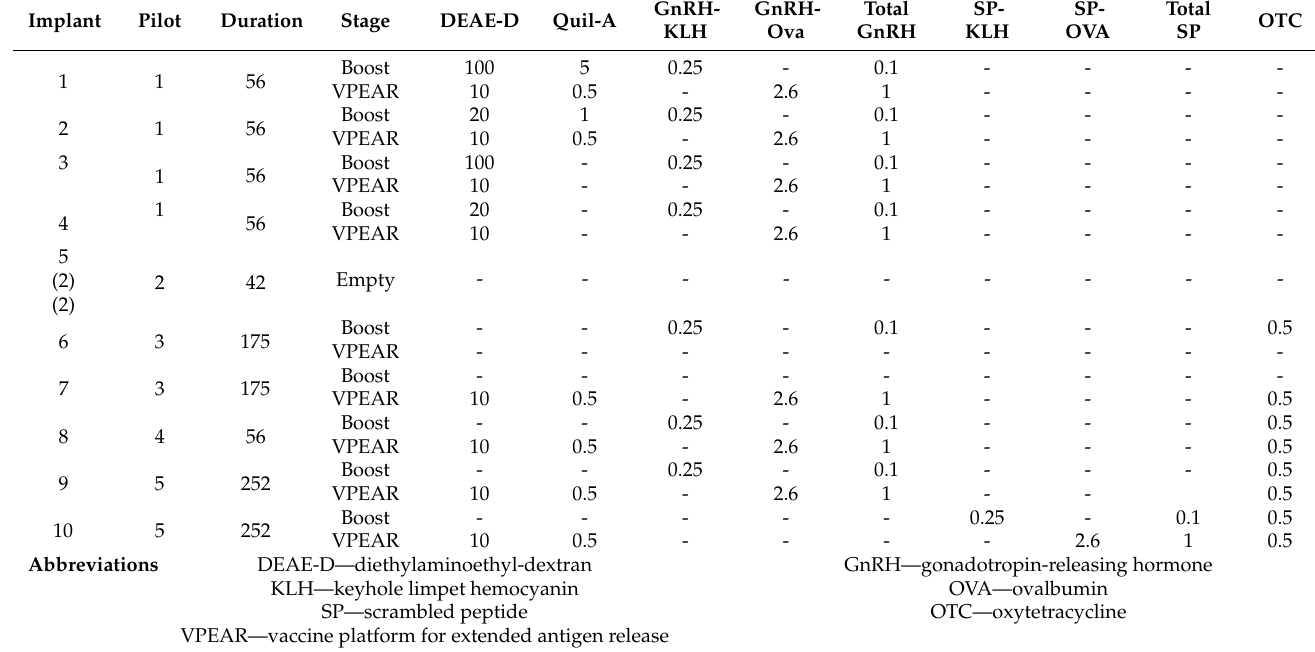
Table 2. A summary of the implanted vaccines used in this study. All values are in milligrams. The duration is given in